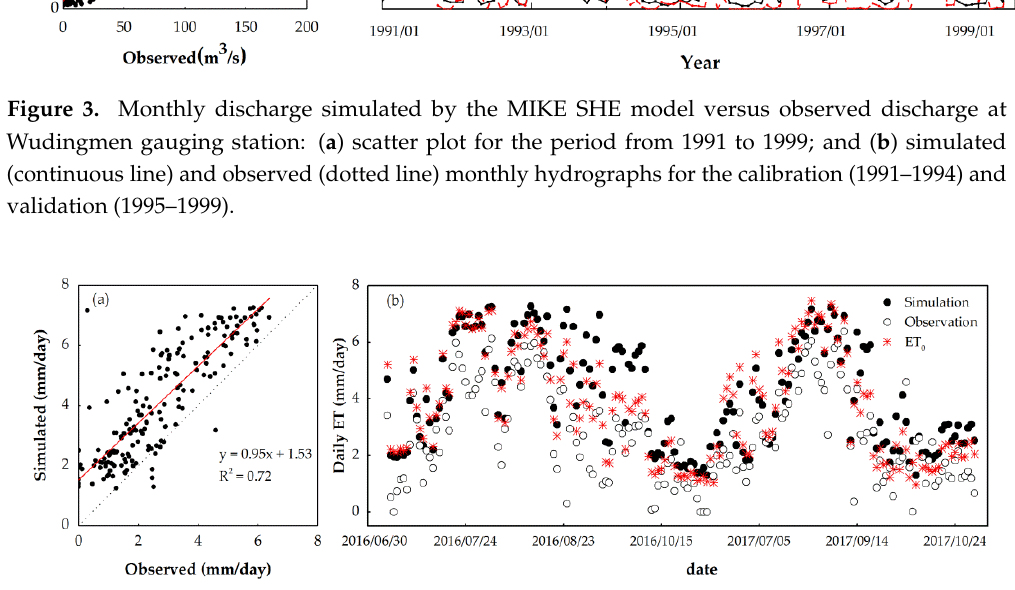
Figure 4. Comparisons between model simulated with observed daily evapotranspiration (ET) in